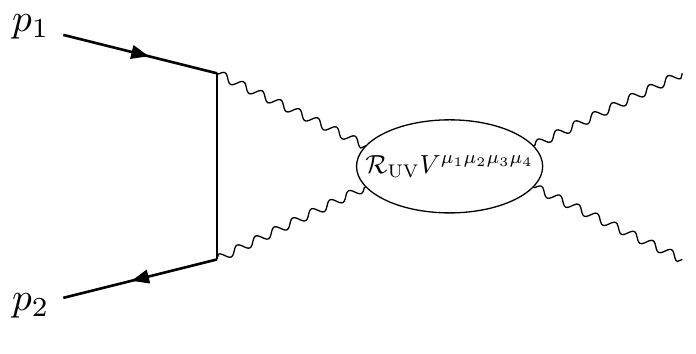
Figure 11. The four-photon UV counterterm inserted into a one-loop